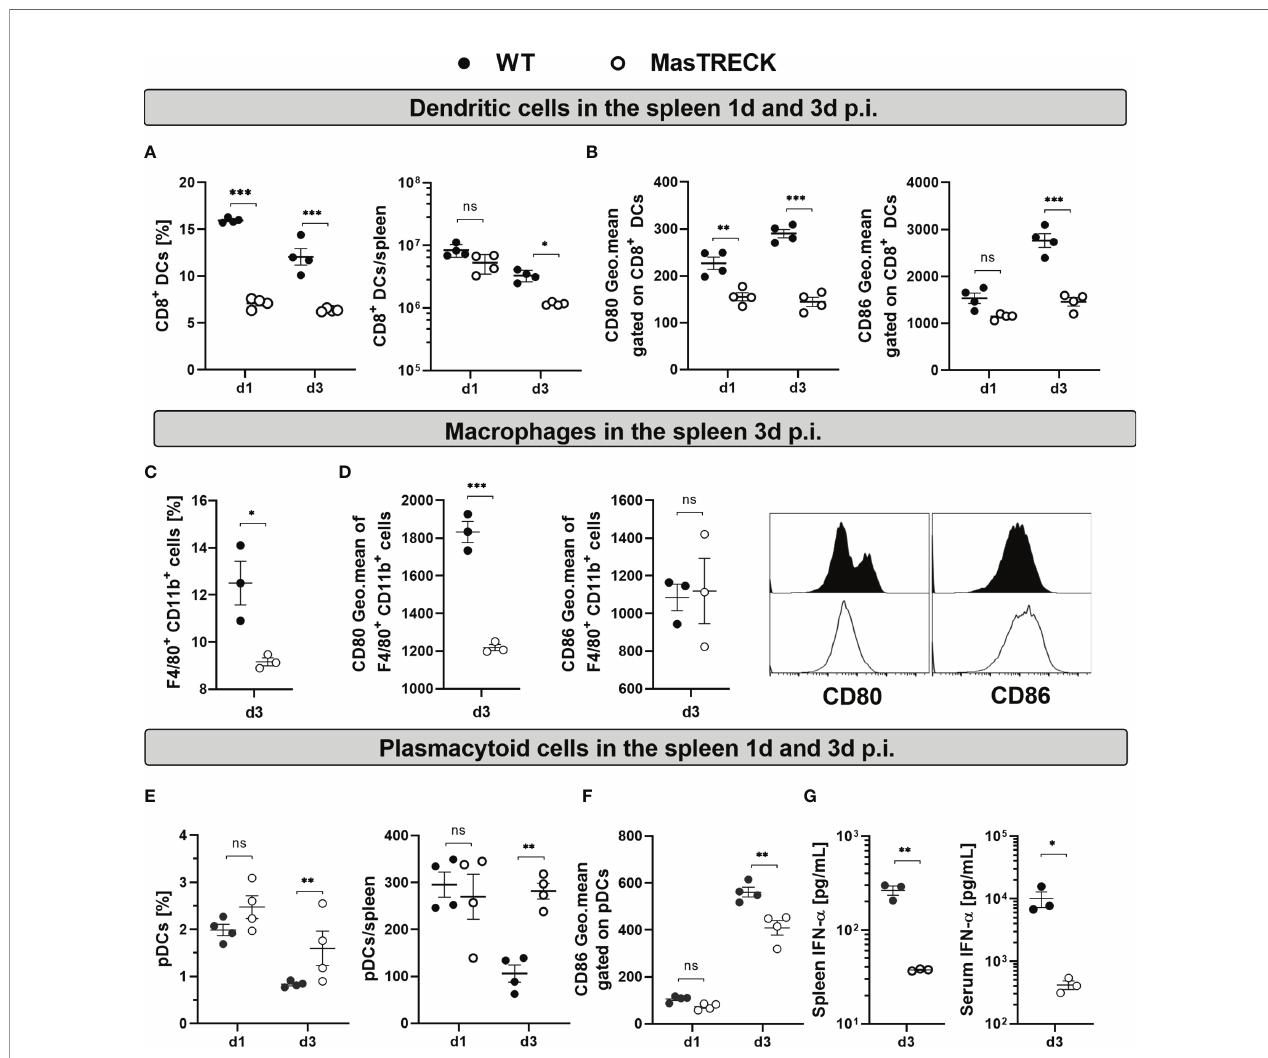
FIGURE 4 | Dendritic cell activation is impaired in mast cell de fi cient mice after LCMV infection. (A) Frequency and absolute number of CD8 + DCs in the spleen of WT and MasTRECK mice on day 1 and 3 post intradermal LCMV infection. (B) Expression levels of CD80 and CD86 (geometric mean of fl uorescence intensity) gated on CD8 + DCs in the spleen of WT and MasTRECK mice at day 1 and 3 post infection. (C) Frequency of splenic macrophages (F4/80 + CD11b + ) and (D) expression levels of CD80 and CD86 (geometric mean of fl uorescence intensity) gated on macrophages as well as representative histograms in the spleen of WT and MasTRECK mice at day 3 post infection. (E) Frequency and absolute number of pDCs in the spleen of WT and MasTRECK mice at day 1 and 3 post infection. (F) Expression levels of CD86 (geometric mean of fl uorescence intensity) gated on pDCs in the spleen of WT and MasTRECK mice at day 1 and 3 post infection. (G) IFN- a concentration in the spleen and serum of WT and MasTRECK mice at day 3 post LCMV infection assessed by magnetic beads multiplex ELISA. All experiments were performed at least twice, and each experimental group included n ≥ 3. Data are representative and expressed as mean ± SEM. Statistically signi fi cant differences are analyzed by t- test and indicated as follows: ns = not signi fi cant, *p < 0.05, **p < 0.01, ***p <